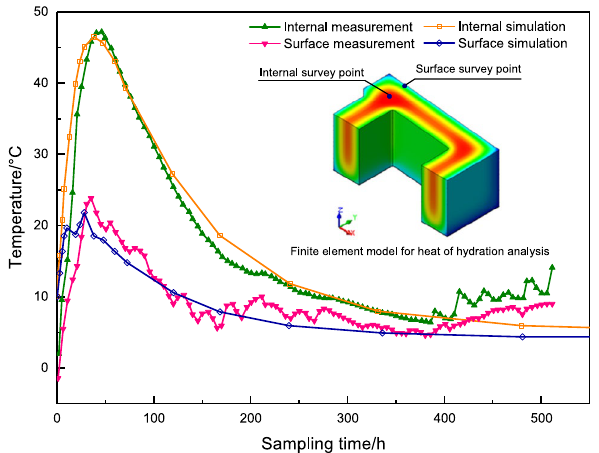
Figure 12. Concrete temperature time history curve.